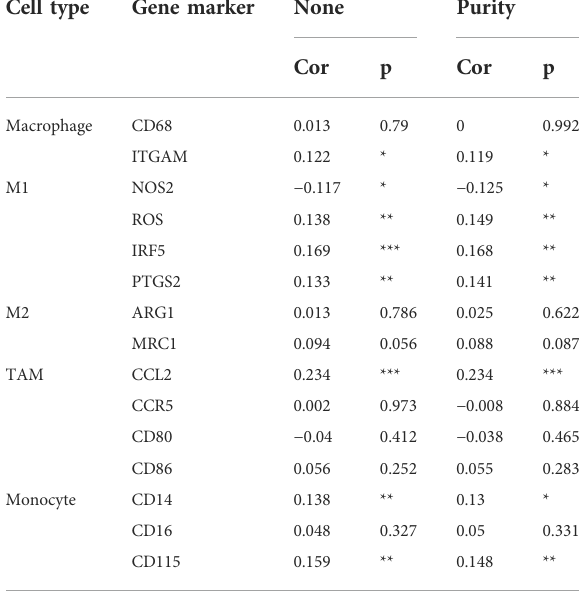
TABLE 2 Correlation analysis between INHBB and macrophage associated markers in TIMER. Cell type